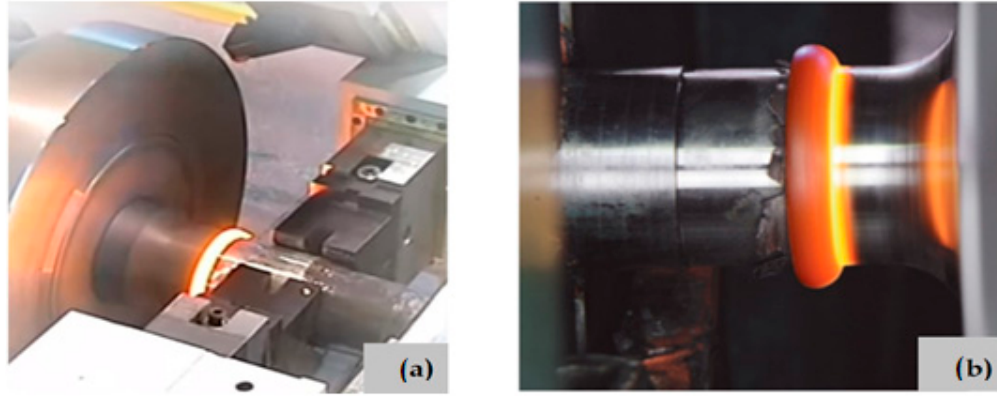
Figure 10. ( a ) Bellino Srl Company and ( b ) Keller und Knappich Augsburg Company (KUKA).